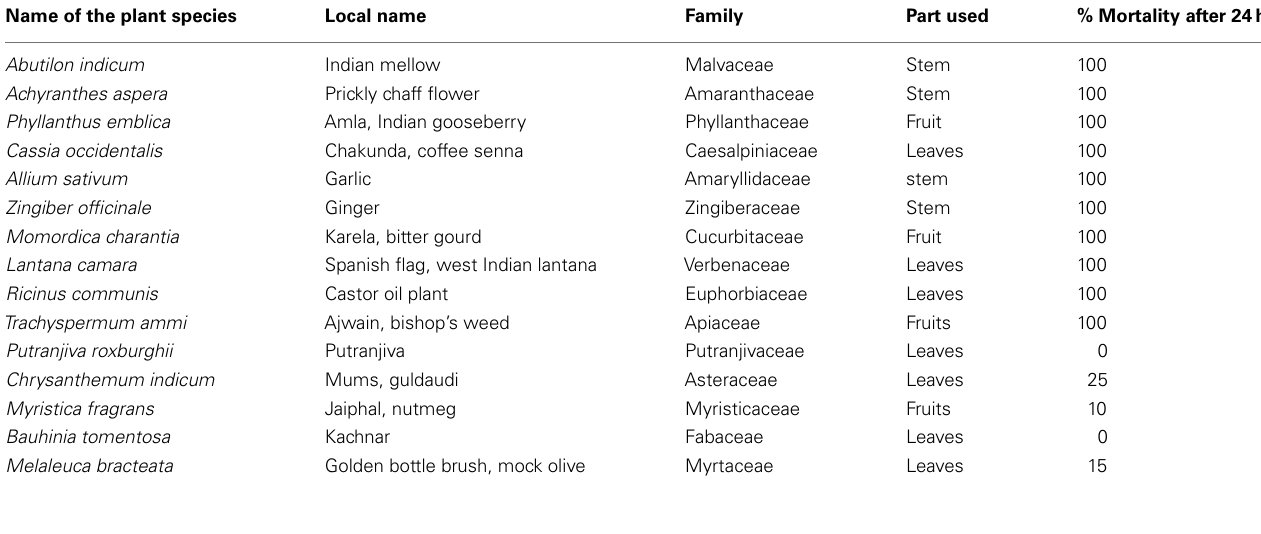
Table 1 | Details of the plant species screened and the larvicidal activity of 1000ppm crude hexane extracts of selected parts of these plant species against dengue vector Aedes aegypti